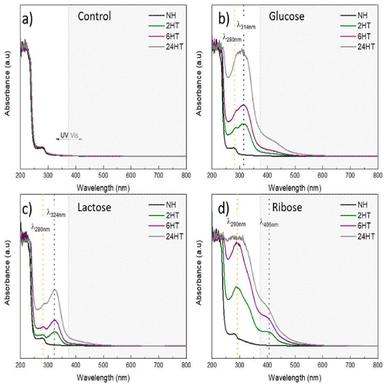
Light absorbance capacity of fish gelatin-based films as a function of saccharide (glucose, lactose, and ribose) and heating time (non-heated (NH), heat-treated (HT) for 2, 6 and 24 h). Films with no saccharide were used as control. (n = 3).